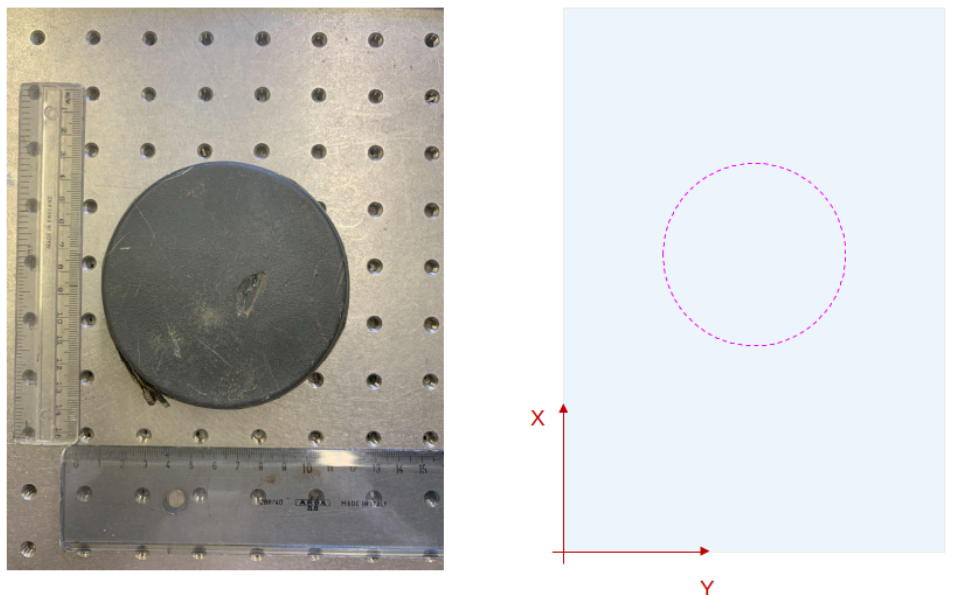
Figure 11. On the left : optical reference of PMN4 landmine. The size is 11 cm diameter, 8 cm height. On the right : the representation of the scanning area (33 cm × 17 cm) and the mine position.